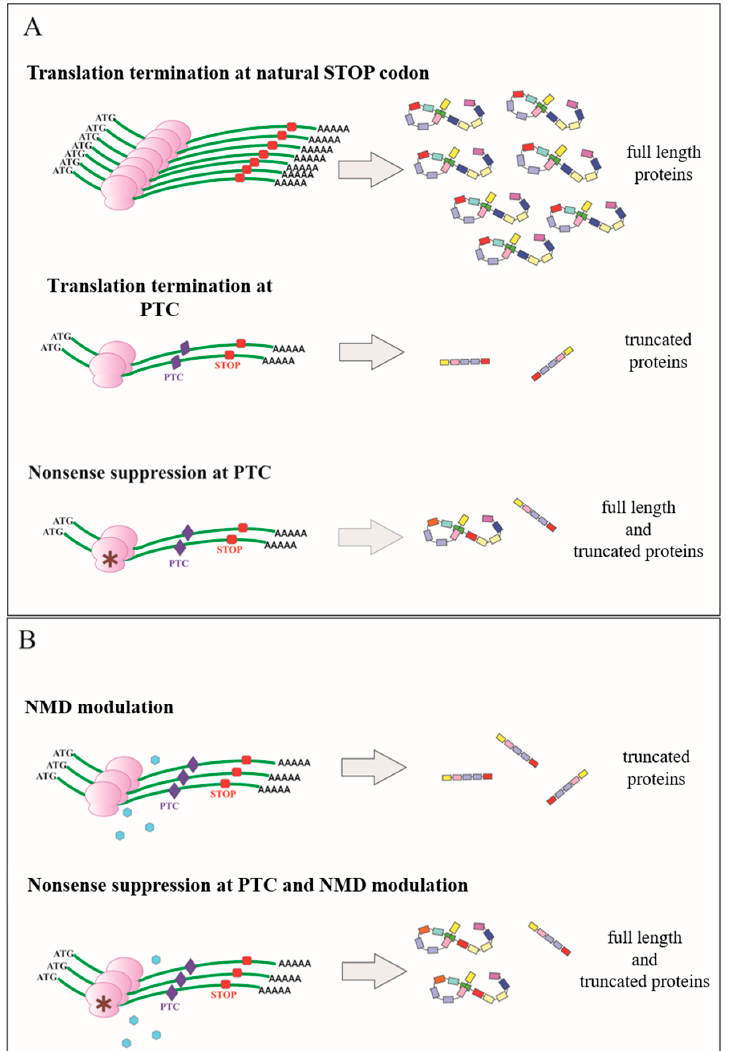
Figure 1. Functional consequences of the premature termination codon (PTC) on gene expression and the basic principle of the nonsense suppression therapeutic approach. ( A ) Natural abundance of physiological mRNA and relevant full length protein production are drastically reduced in the presence of a PTC. The premature arrest of translation results in the synthesis of truncated protein. Nonsense suppression at PTC restores to some extent full length protein synthesis. ( B ) Negative modulation of the nonsense mRNA mediated decay pathway (NMD) attenuates mRNA destabilization and increases mRNA abundance. The concomitant presence of a compound promoting nonsense suppression allows more full length protein